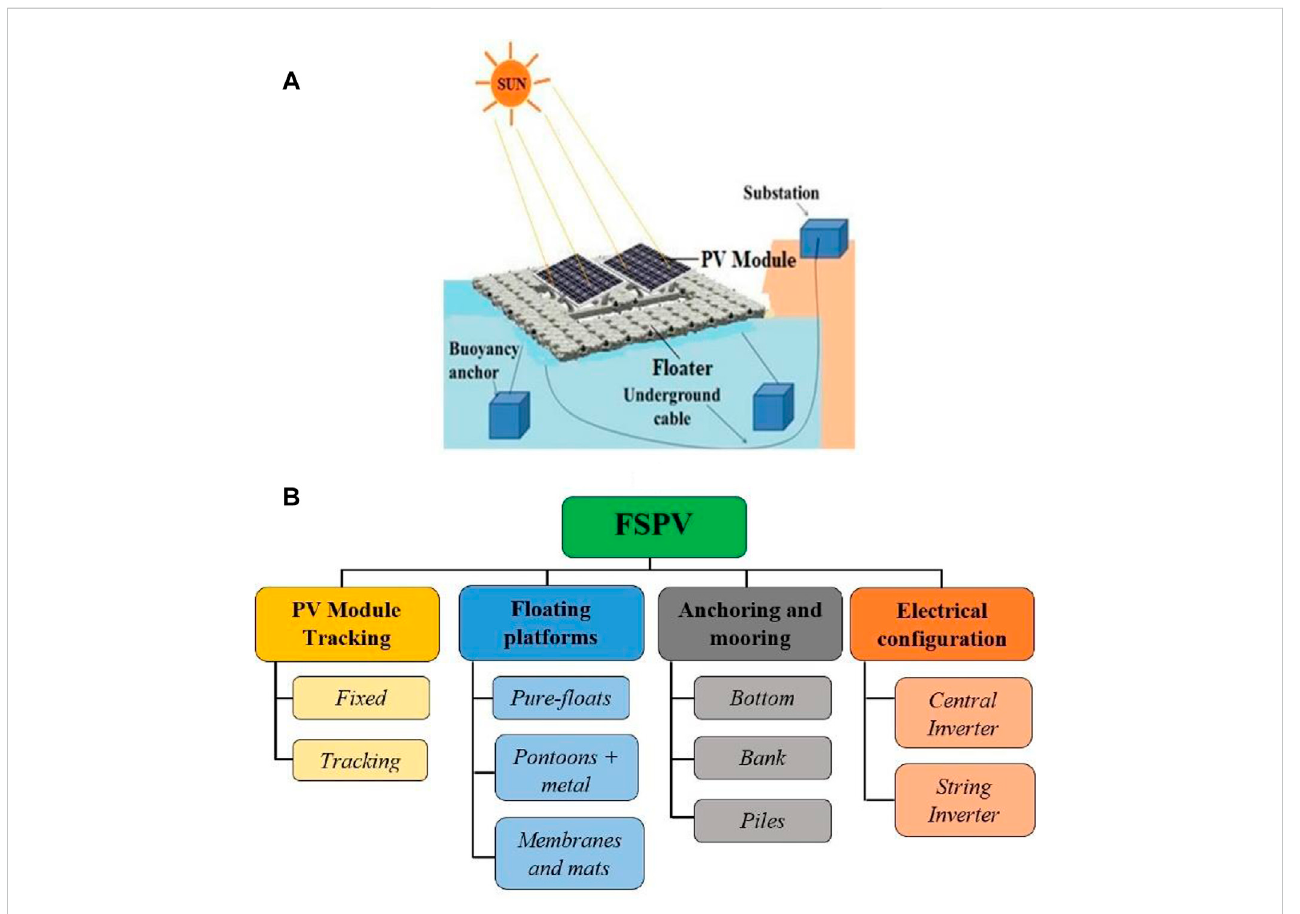
FIGURE 1 (A) A schematic representation of a typical fl oating solar photovoltaic system with its essential components; (B) Floating solar photovoltaic system classi fi cation based on the components. Reprinted with permission from the fi rst author ’ s own source in ref (Kumar et al., 2022)